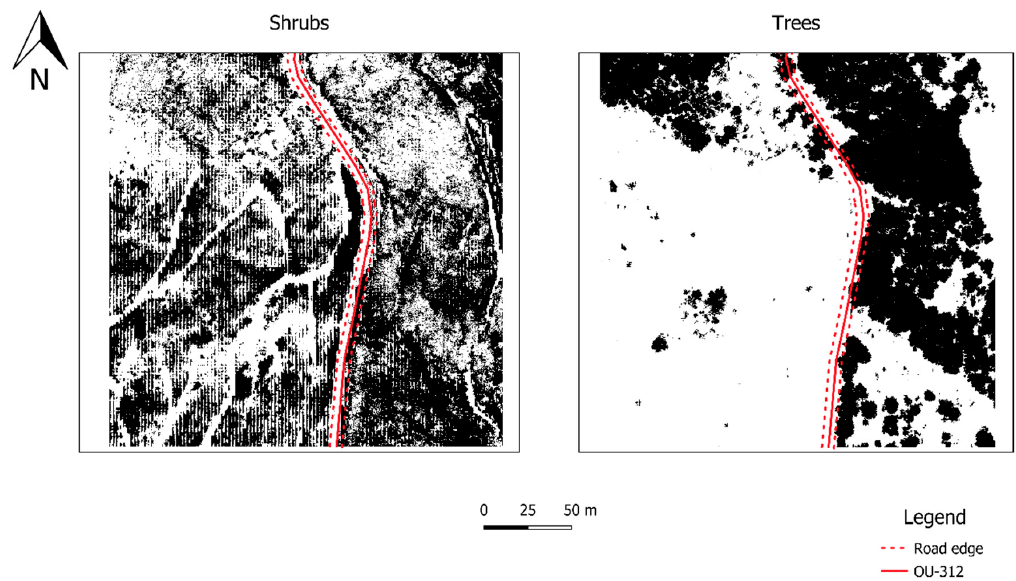
Figure 8. Binary image (0.25 m of resolution) of vegetation points in study area. Black pixels represent